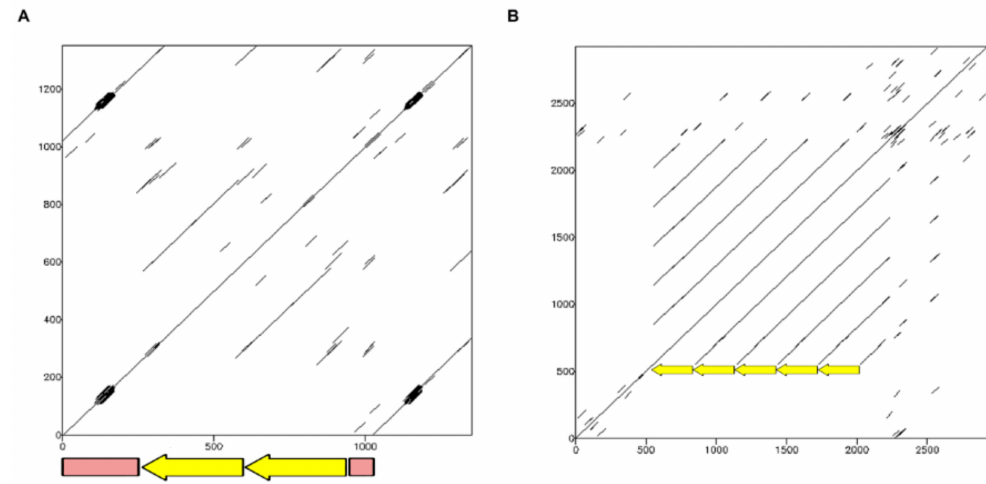
Figure 1. ( A ) Dotplot of one of the clusters for TinfSat04-1000 obtained in the RepeatExplorer analysis of the T. infestans genome, showing the presence of two internal repeats of about 300 bp (arrows) and an unrelated sequence of about 400 bp (box) within the 1 kb repeat; ( B ) Dotplot of the internal region of a R. prolixus superconting that shows similarity with the TinfSat04-1000 satDNA of T. infestans , revealing repeats with a periodicity of about 300 bp